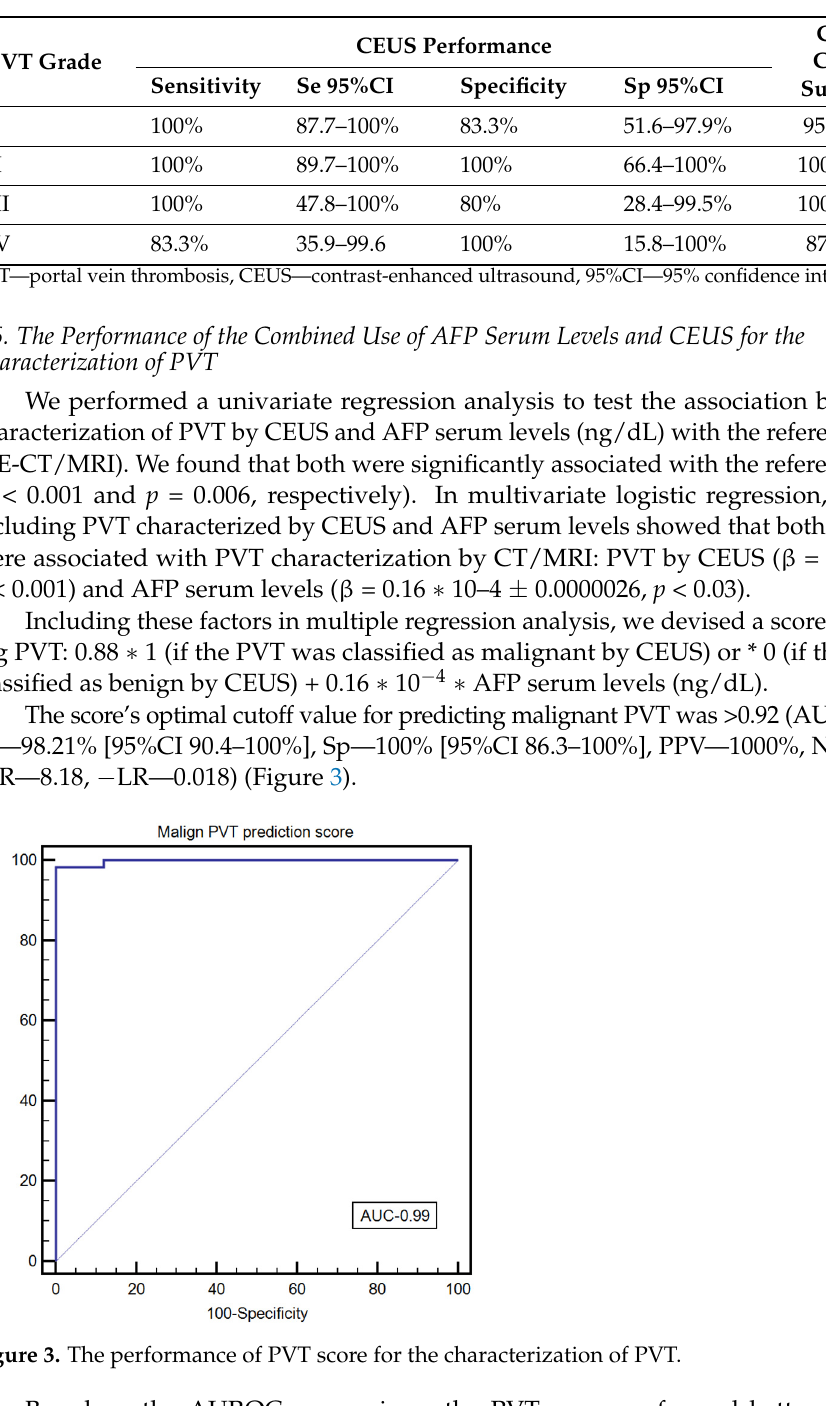
Table 5. Performance of CEUS for the characterization of PVT and distribution of correctly classified subjects according to PVT grade.